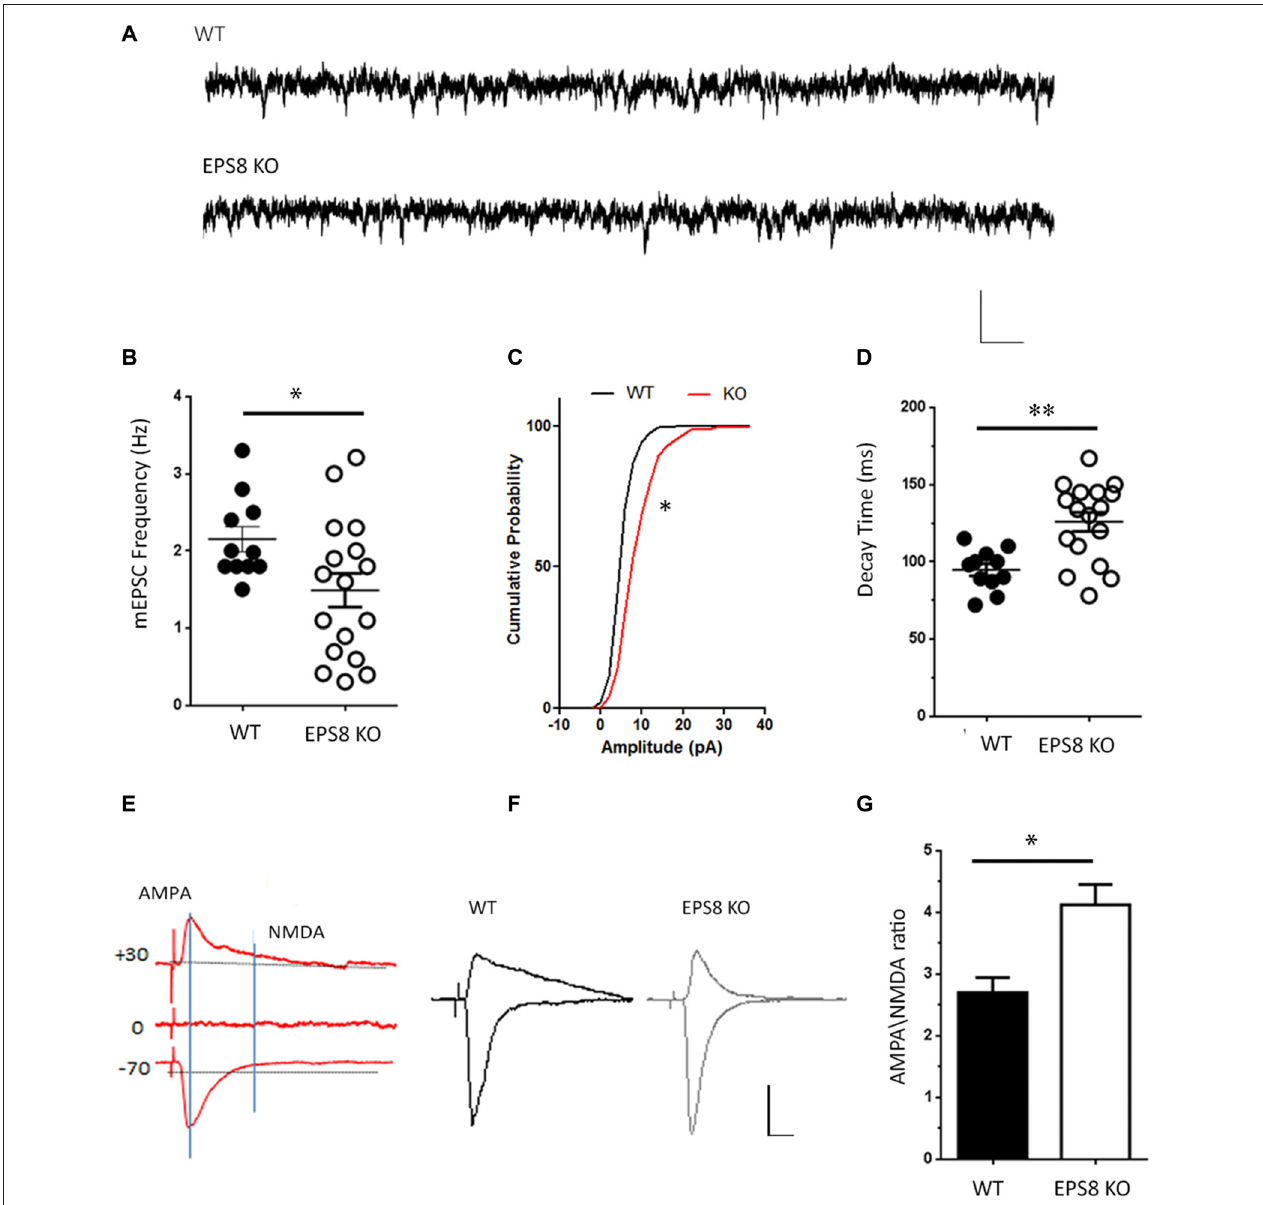
FIGURE 1 | Epidermal growth factor receptor pathway substrate 8 (EPS8) deficiency reduces N-methyl-d-aspartate (NMDA)-mediated synaptic activity. (A) Representative traces of NMDA receptor-mediated mEPSCs (NMDA-mEPSC) recorded from mature wild type (WT) and Eps8 knock out mice (Eps8 KO) primary hippocampal neurons. Scale bars 10 pA, 50 ms. (B–D) Quantitation of mEPSC frequency, cumulative probability plot of mEPSC amplitudes and decay time showing a reduced frequency (Unpaired t -test, ∗ P = 0.0374) and an increased amplitudes (Kolmogorov-Smirnov test, ∗ = 0.0348, D = 0.4500) and decay time